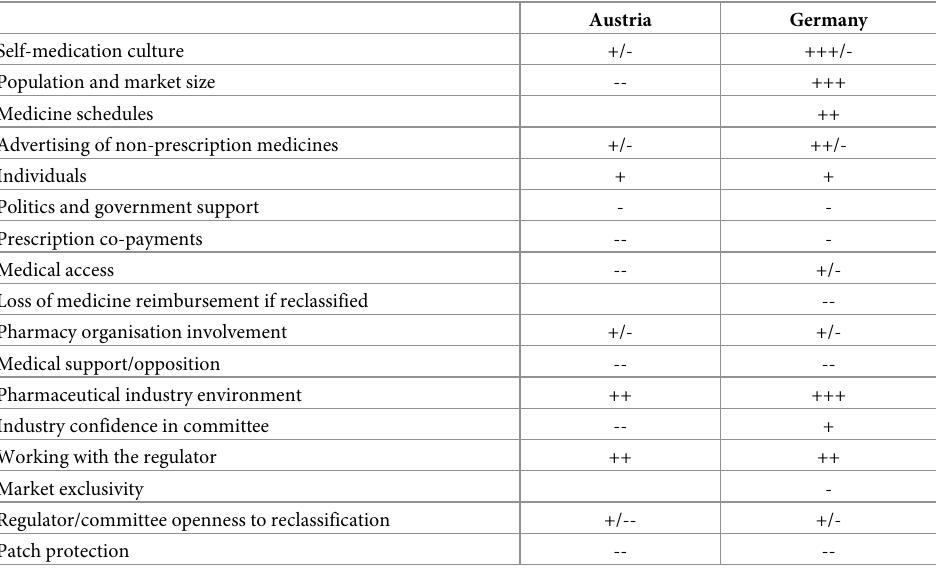
Table 3. Comparison of critical enablers and barriers to reclassification across Austria and Germany �